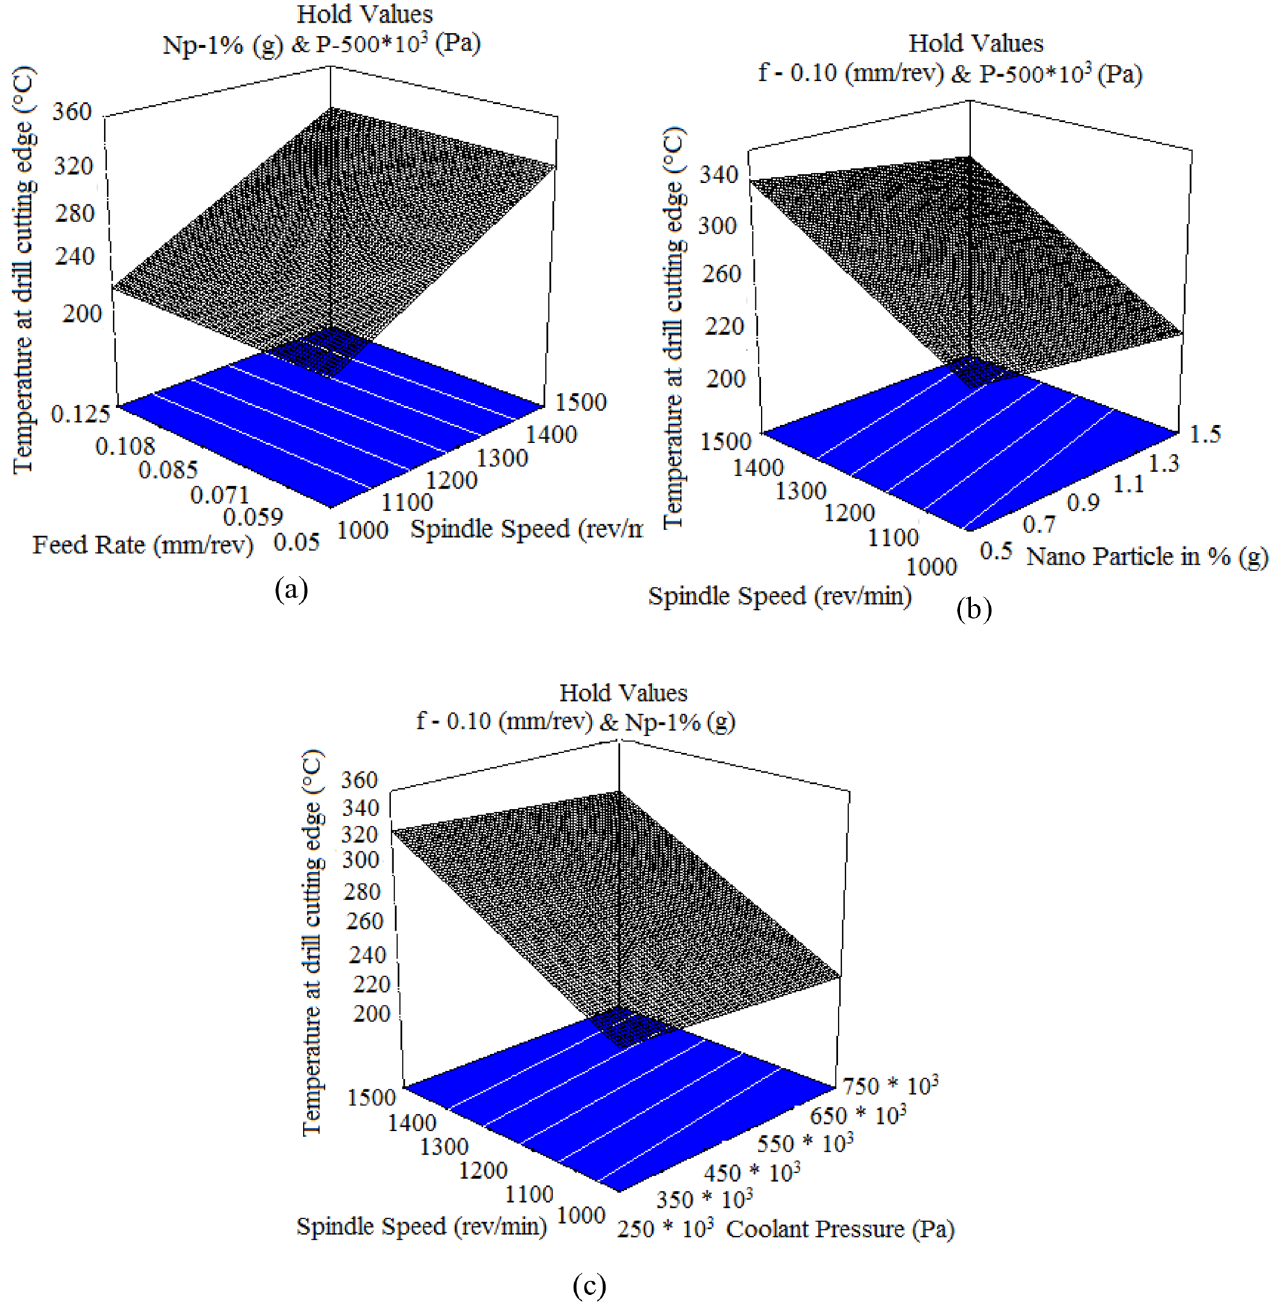
Fig. 5. (a-c) 3D plots for Q ( ° C): (a) 3D plots for Q ( ° C) at P-500* 10 3 (Pa), Np-1% (g), (b) 3D plots for Q ( ° C) at f-0.10mm/rev, p-500* 10 3 (Pa), (c) 3D plots for Q ( ° C) at f-0.10mm/rev, Np-1%